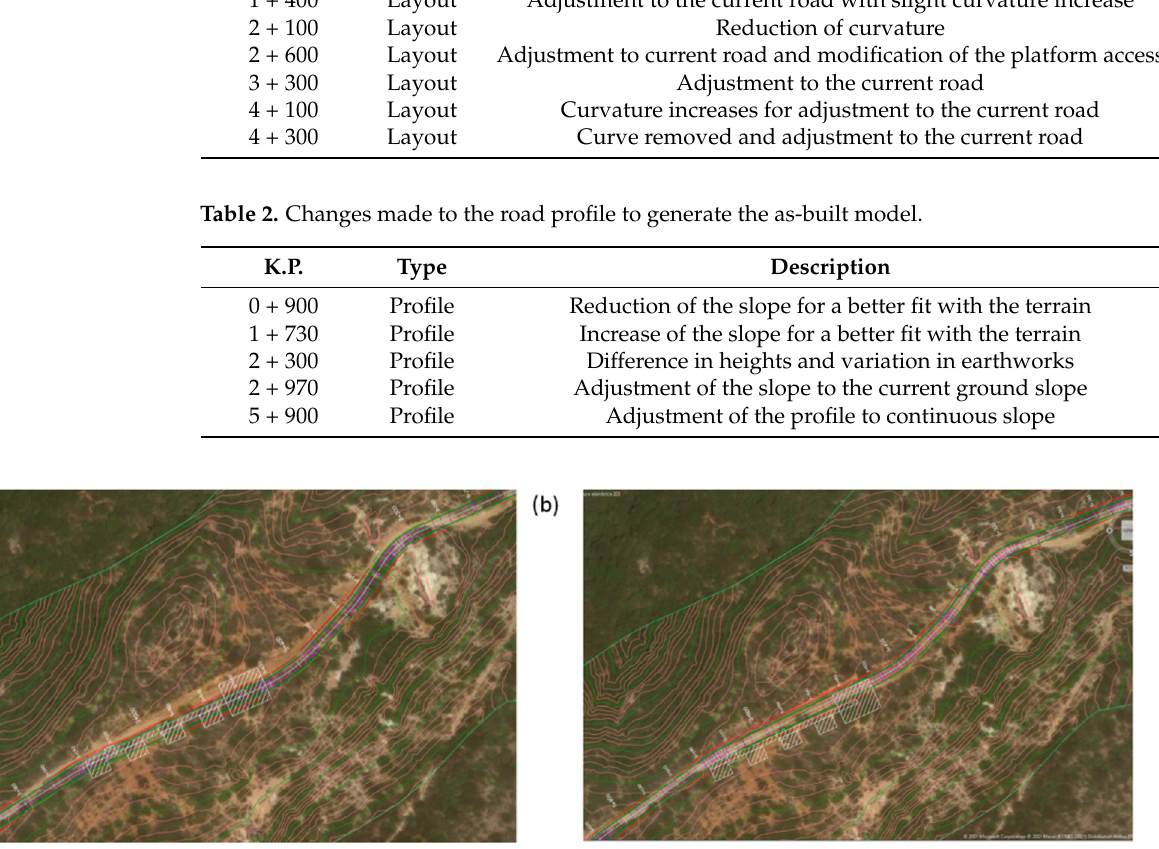
Figure 4. Changes to the access road layout plan view (K.P. 3 + 300 to 3 + 600): ( a ) initial design; ( b ) modified design.